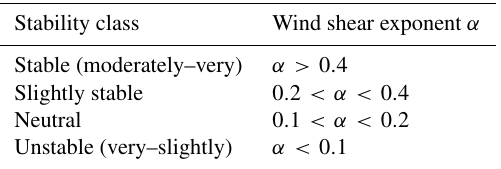
Table 2. Criteria for stability classes as a function of the wind shear exponent α according to van den Berg